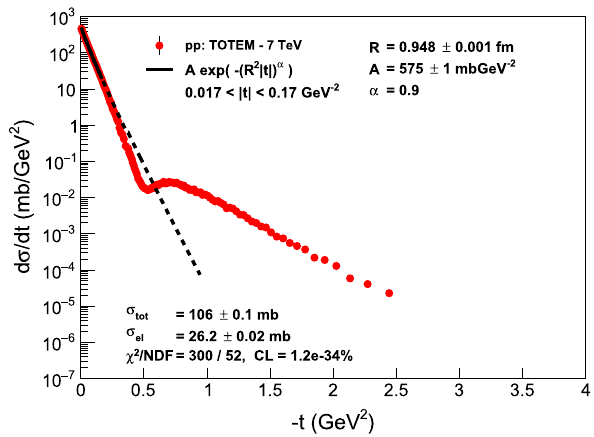
Fig. 41 Zeroth-order Lévy fits to the cone region of the differential cross-section data on pp elastic scattering at α = 0 . 9, A and R being free fit parameters